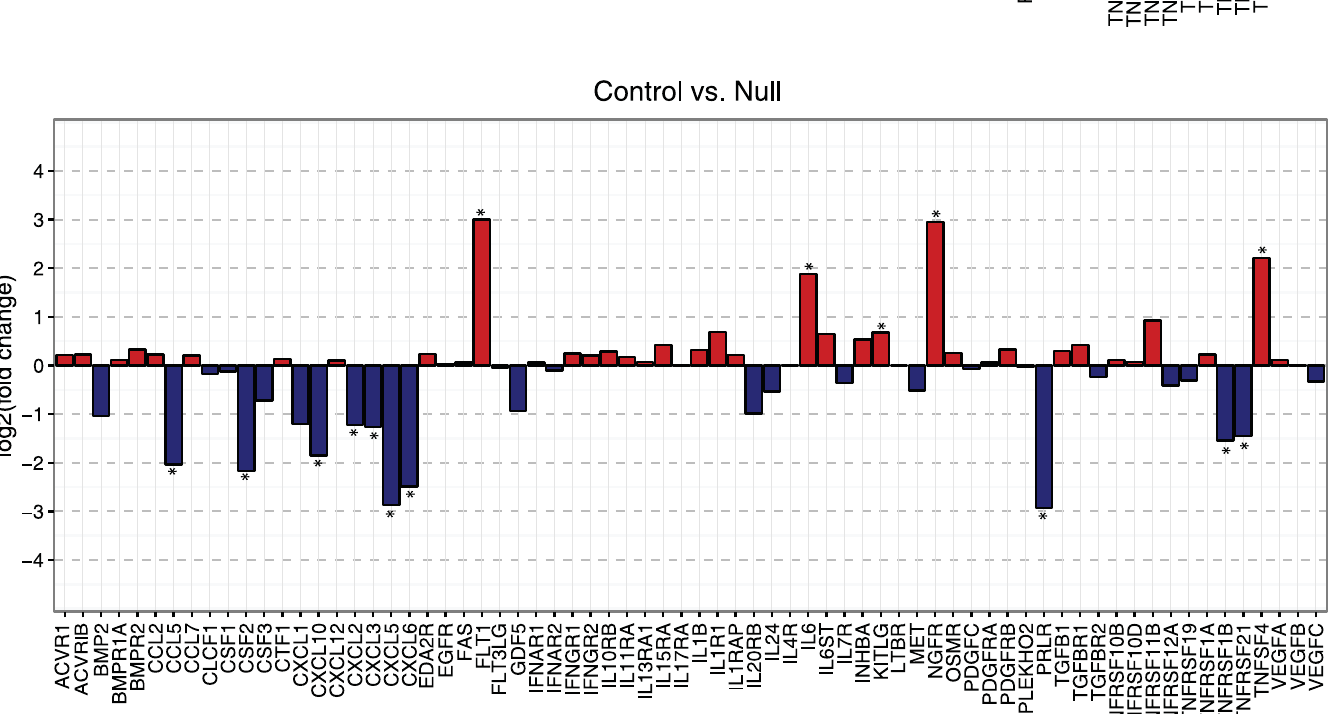
PLOS ONE | https://doi.org/10.1371/journal.pone.0189664 December15,